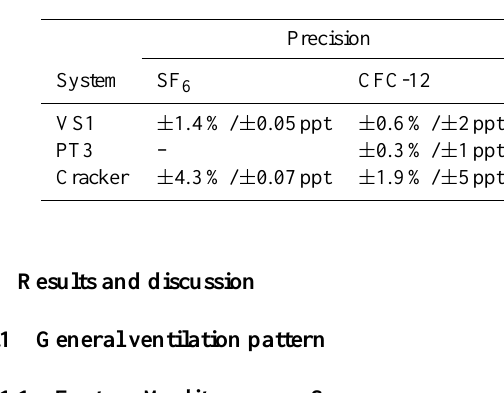
Table 2. Precision of CFC-12 and SF 6